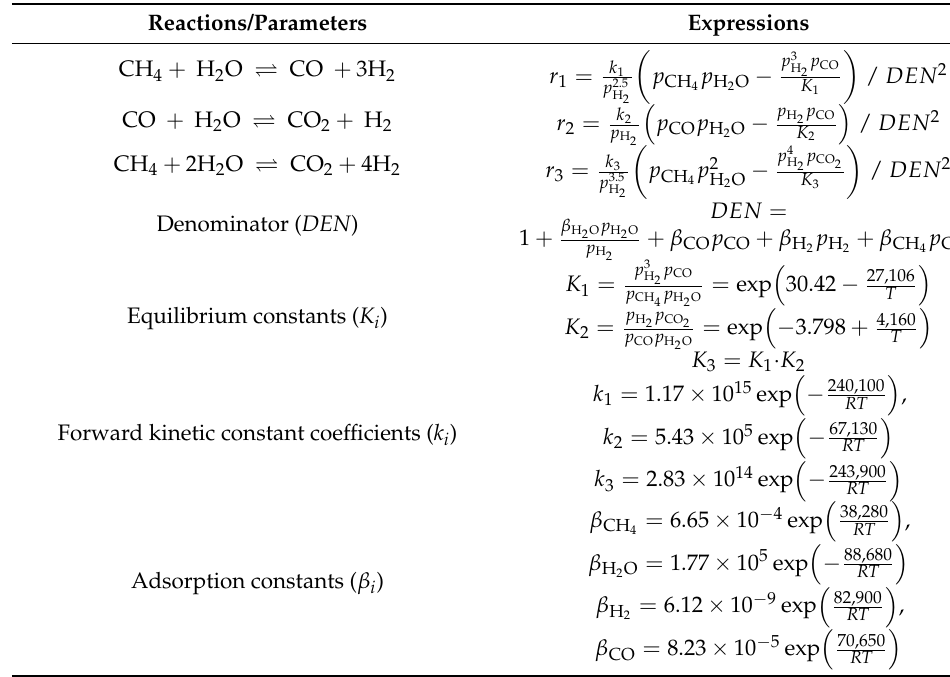
Table A4. Reaction kinetics model and